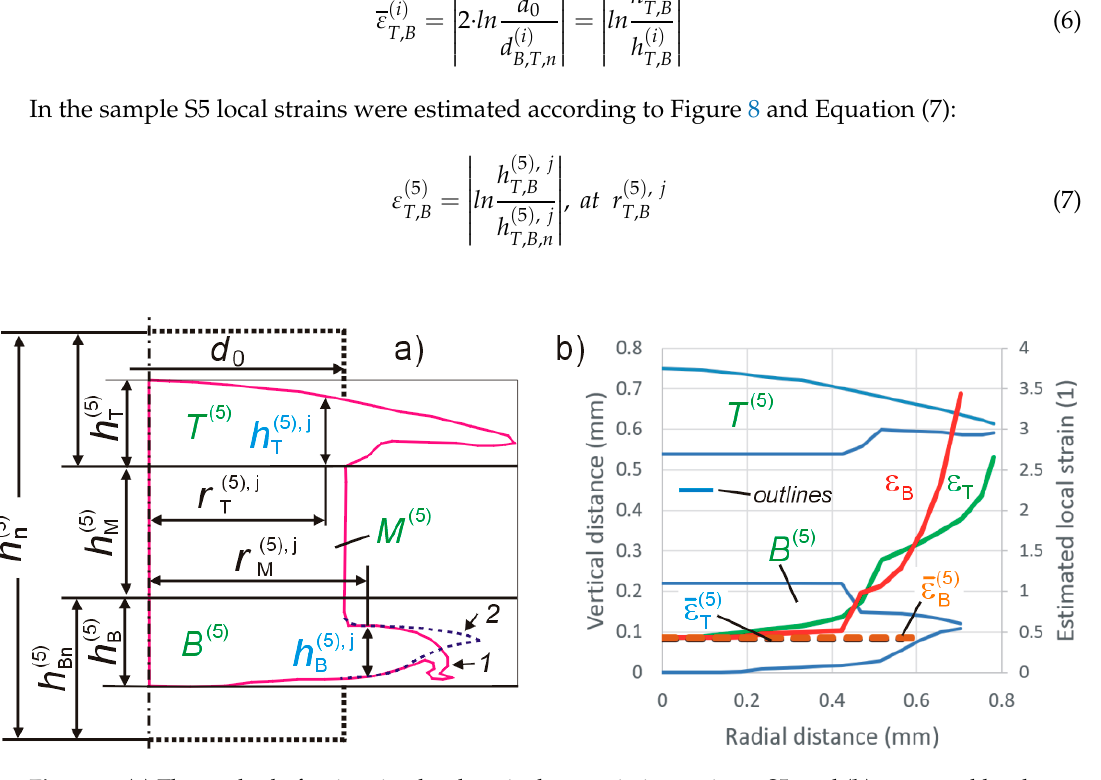
Figure 8. ( a ) The method of estimating local equivalent strain in specimen S5; and ( b ) mean and local equivalent strain distribution in the specimen